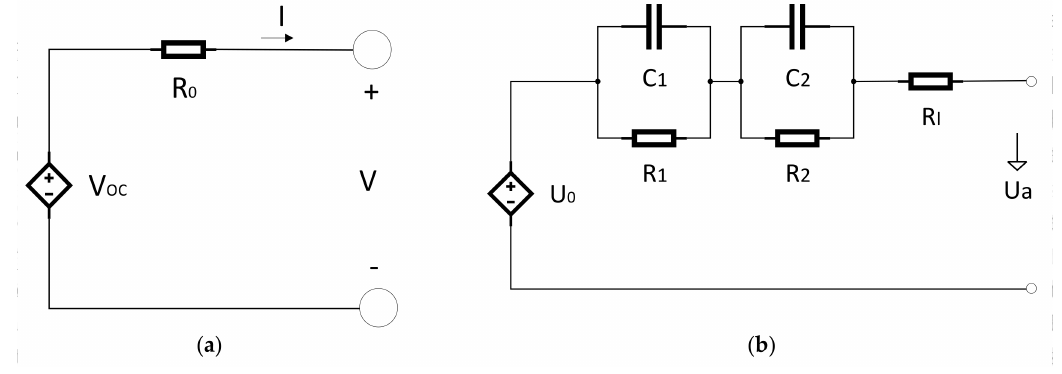
Figure 1. ( a ) Internal resistance model ( b ) Equivalent circuit model.